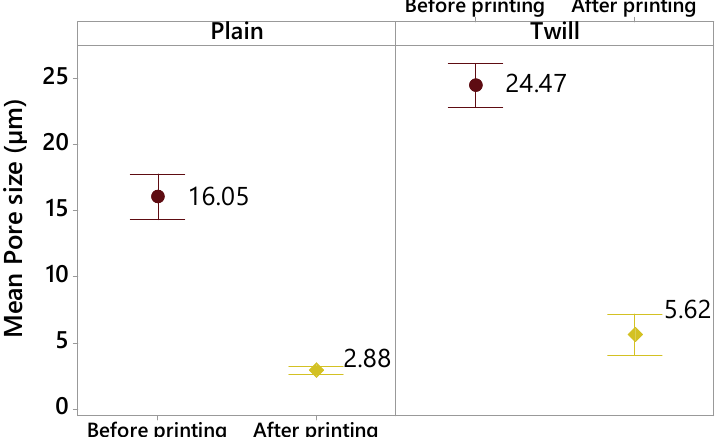
Figure 9. Effect of (A) pattern, (B) platform temperature in °C, and (C) weft density in picks/inch on ( a ) pore size of the fabric prior to 3D printing process and ( b ) 3D-PPOT materials after 3D printing process, obtained through pareto analysis of Minitab 17. AC and BC represent the interaction between mean pore size reduced from 21.48 µ m to 2.7 µ m (for 14 picks / inch) and from 19.03 µ m to 5.8 µ m (for the factors A and C and, B and C, respectively. 18 picks / inch).